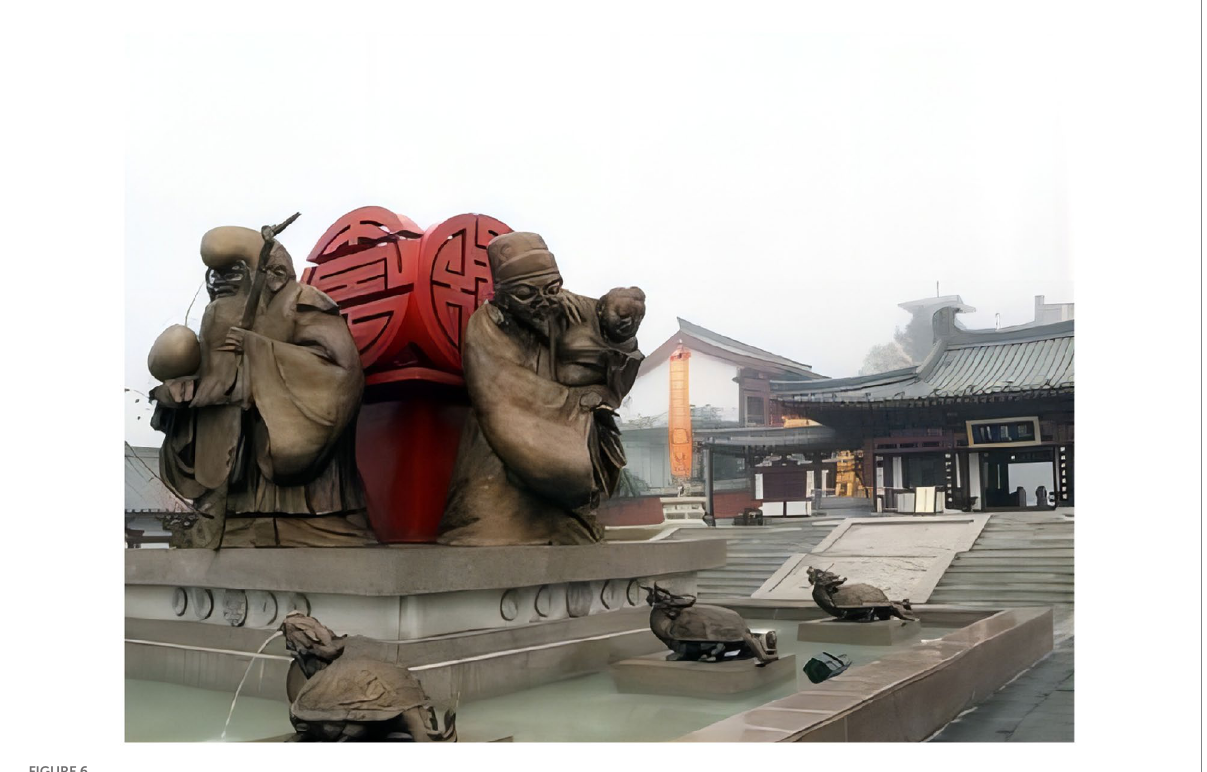
FIGURE 6 Mount Zhongnan (historical environment).